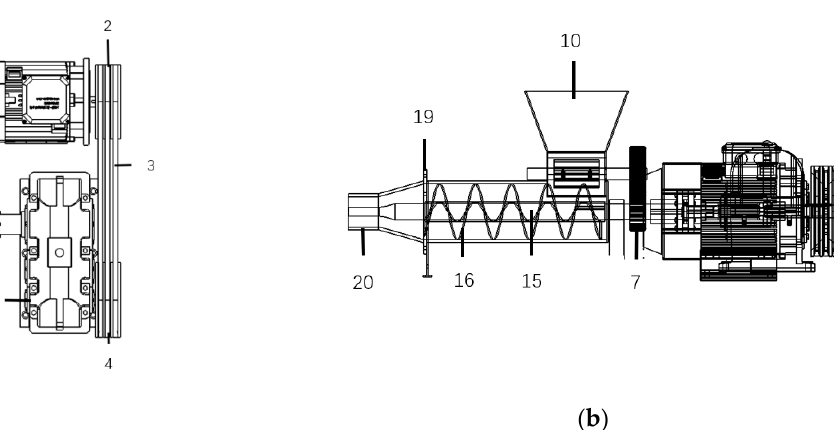
Figure 1. Structural diagram of a compound pipe-forming device for underground irrigation: ( a ) top view of the device; ( b ) left view of the device: (1) three-phase asynchronous motor; (2) driving pulley; (3) belt; (4) driven pulley; (5) reducer; (6) coupling; (7) driving gear; (8) driven gear 1; (9) driven gear 2; (10) feed barrel; (11) rotating mixing shaft 1; (12) mixing plate; (13) rotating mixing shaft 2; (14) mixing plate; (15) winch shaft; (16) auger blade; (17) housing; (18) support frame; (19) flange; (20) discharge drum.